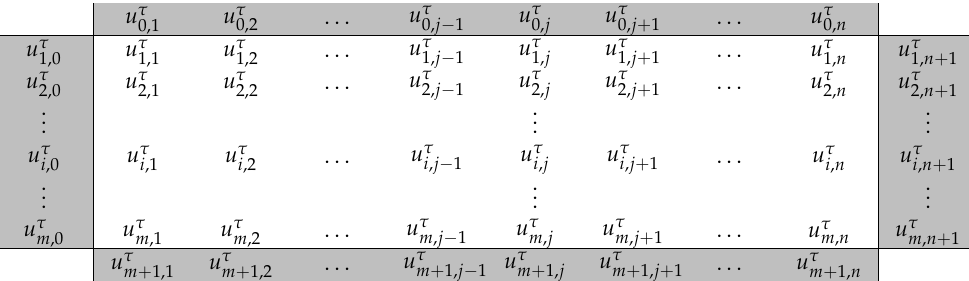
Table 9. Discretization in time τ for the two-dimensional heat